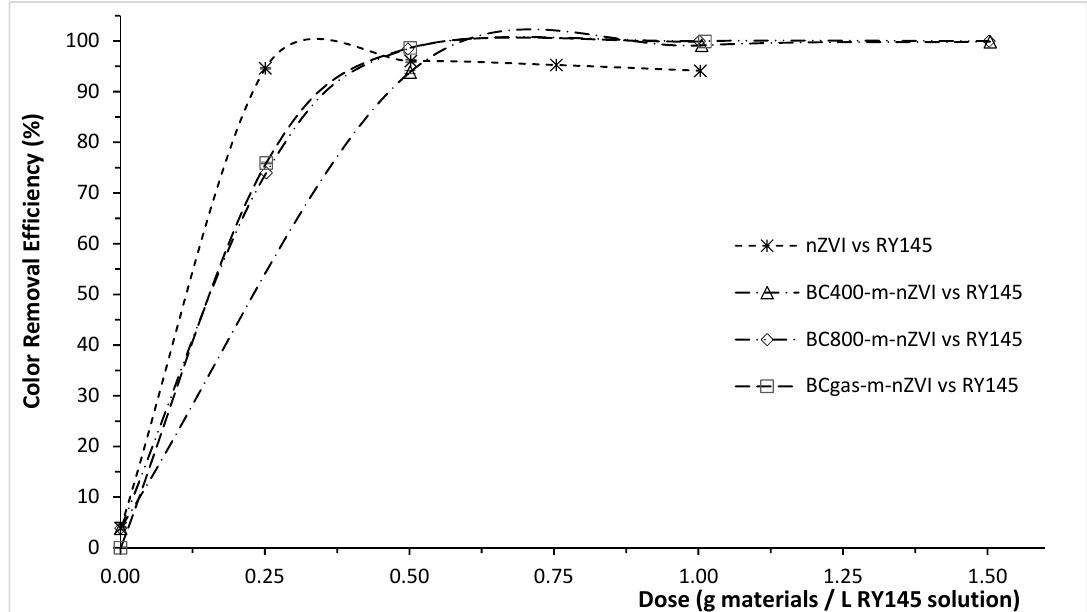
0102030405060708090100